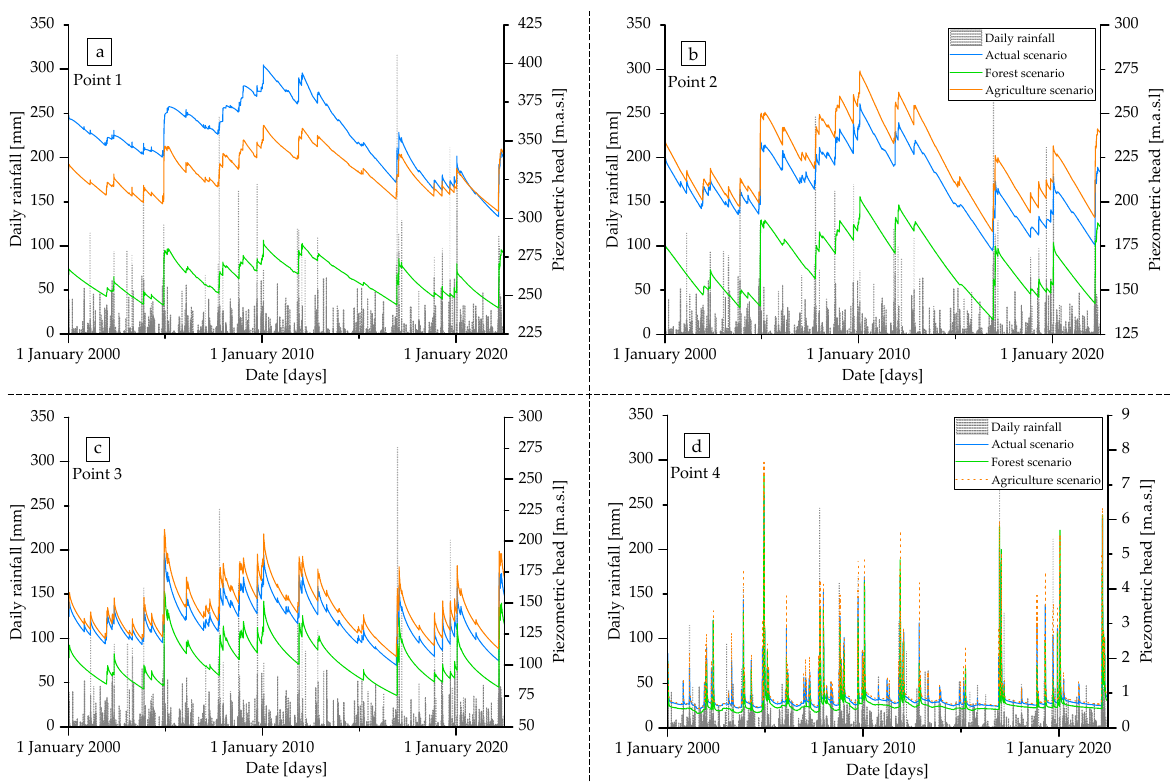
Figure 9. Piezometric heads variation at different sections of the Almudaina-Segaria aquifer, from west to east. Groundwater hydrographs for: ( a ) point 1; ( b ) point 2; ( c ) point 3; and ( d ) point 4. The exact locations are given in Figure 8.